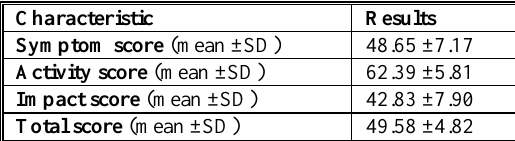
Table 3. Assessment of health-related quality of life of COPD patients enrolled in this study.